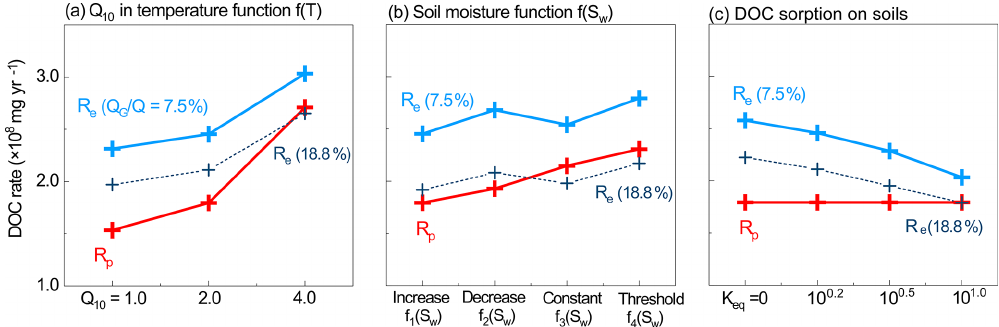
Figure 13. Total annual R p (red) and R e (blue) under two groundwater volume contribution conditions ( Q G /Q = 7 . 5% and 18.8%) for three different variables: (a) soil T , (b) soil moisture, and (c) sorption equilibrium K eq . R p was not influenced by a deeper groundwater contribution, so there is only one curve for each variable. R p has higher dependence on temperature than on soil moisture function form and sorption